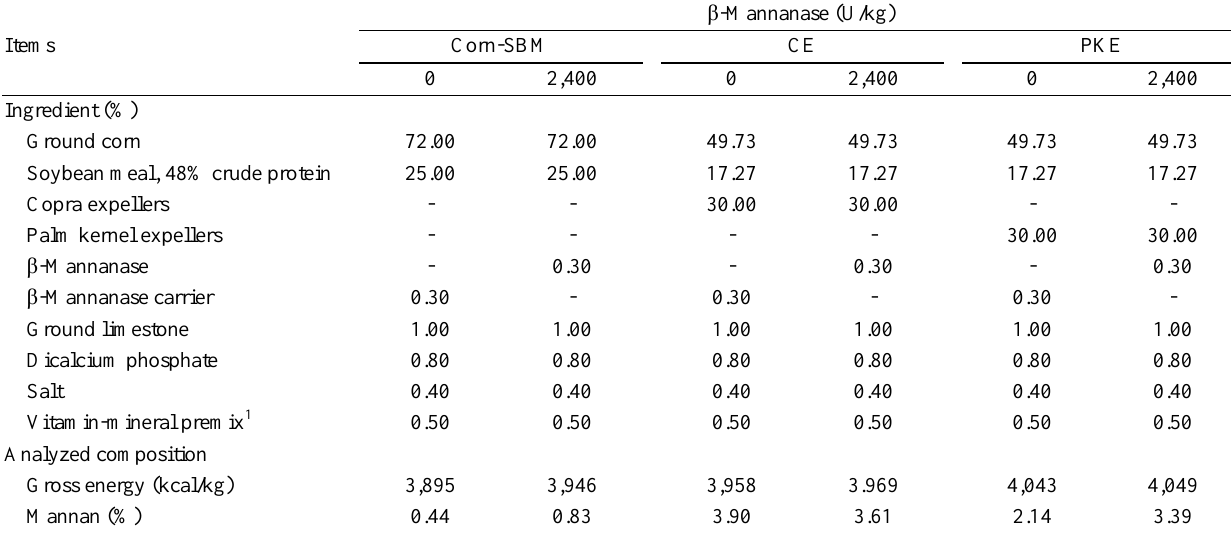
Table 2. Ingredient composition of experimental diets, as-fed